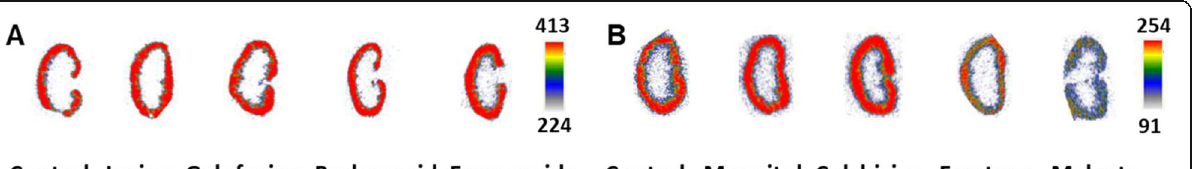
Fig. 2 Representative ex vivo autoradiograms of the kidney sections. NMRI mice were pre- or co-injected with lysine, Gelofusine, probenecid, furosemide ( a ) and mannitol, colchicine, fructose, maleate ( b ), and [ 99m Tc]Tc(CO) 3 -G3 and sacrificed at 4 h pi. The control group was injected with [ 99m Tc]Tc(CO) 3 -G3